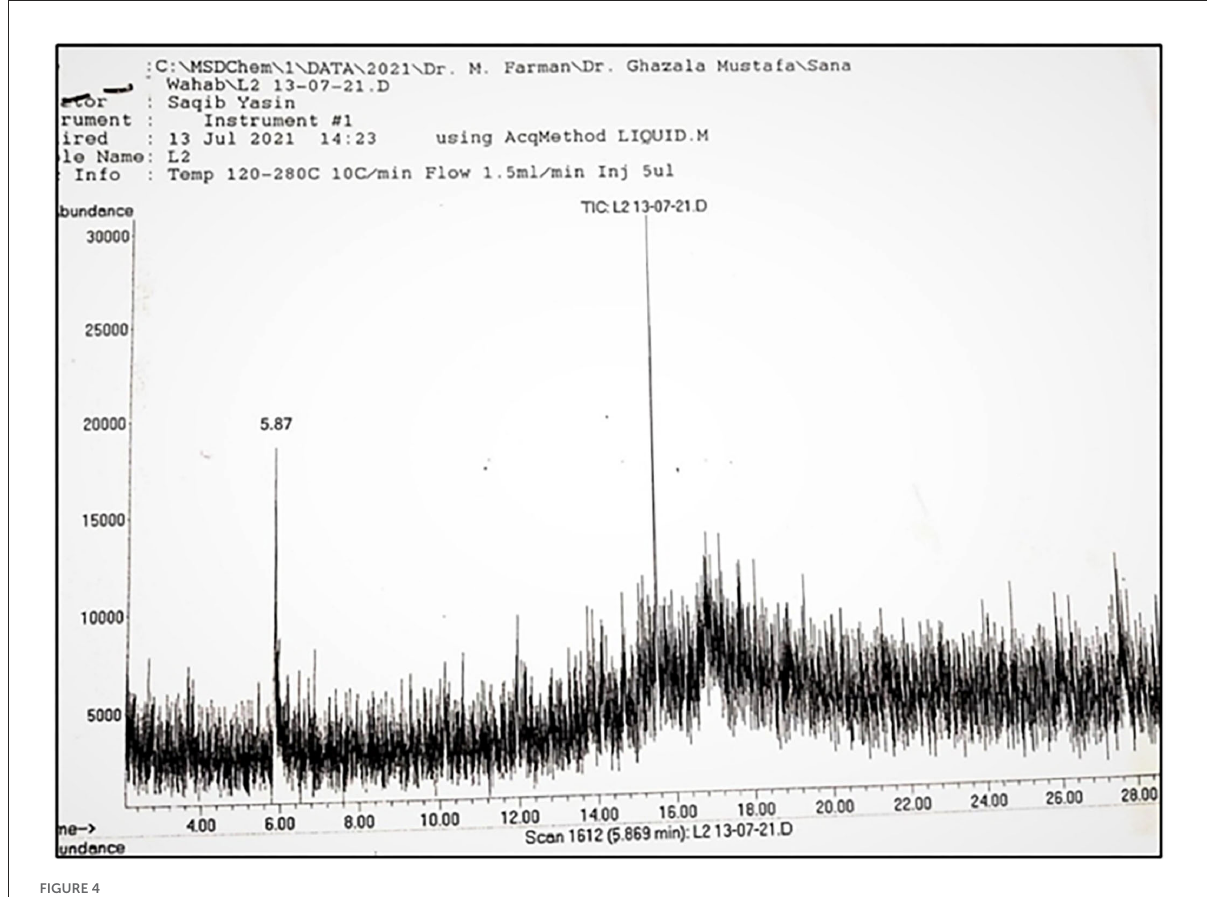
FIGURE4 Main spectrum obtained through GC-MS of seed sample.